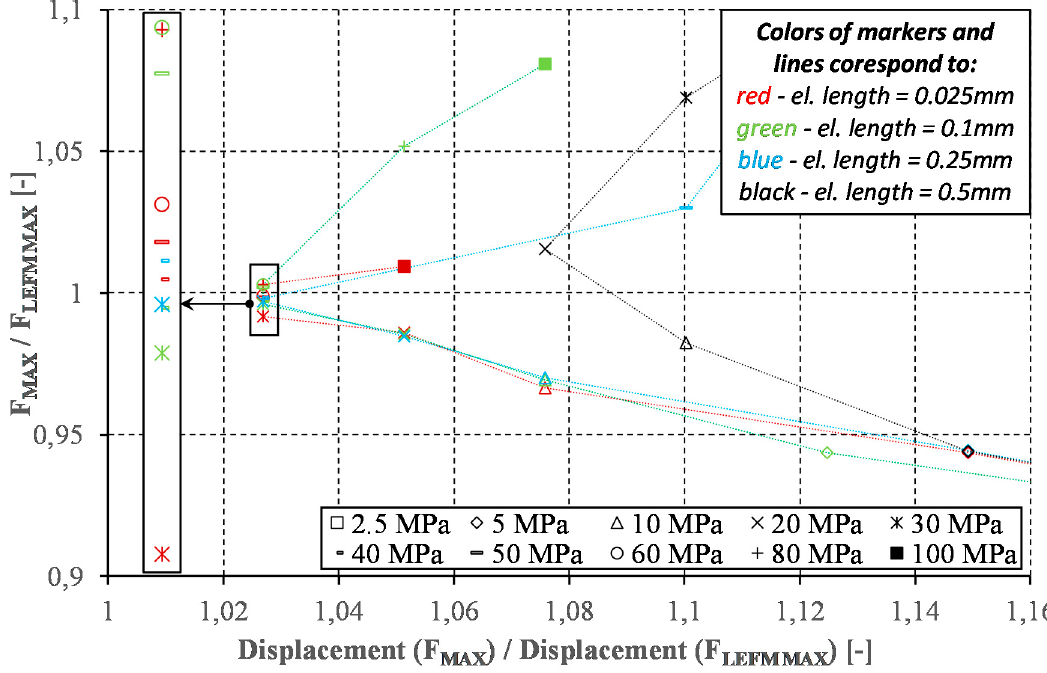
Figure 8. Influence of the finite element size and the values of the traction stress on the solution’s compatibility with the analytical model (LEFM).